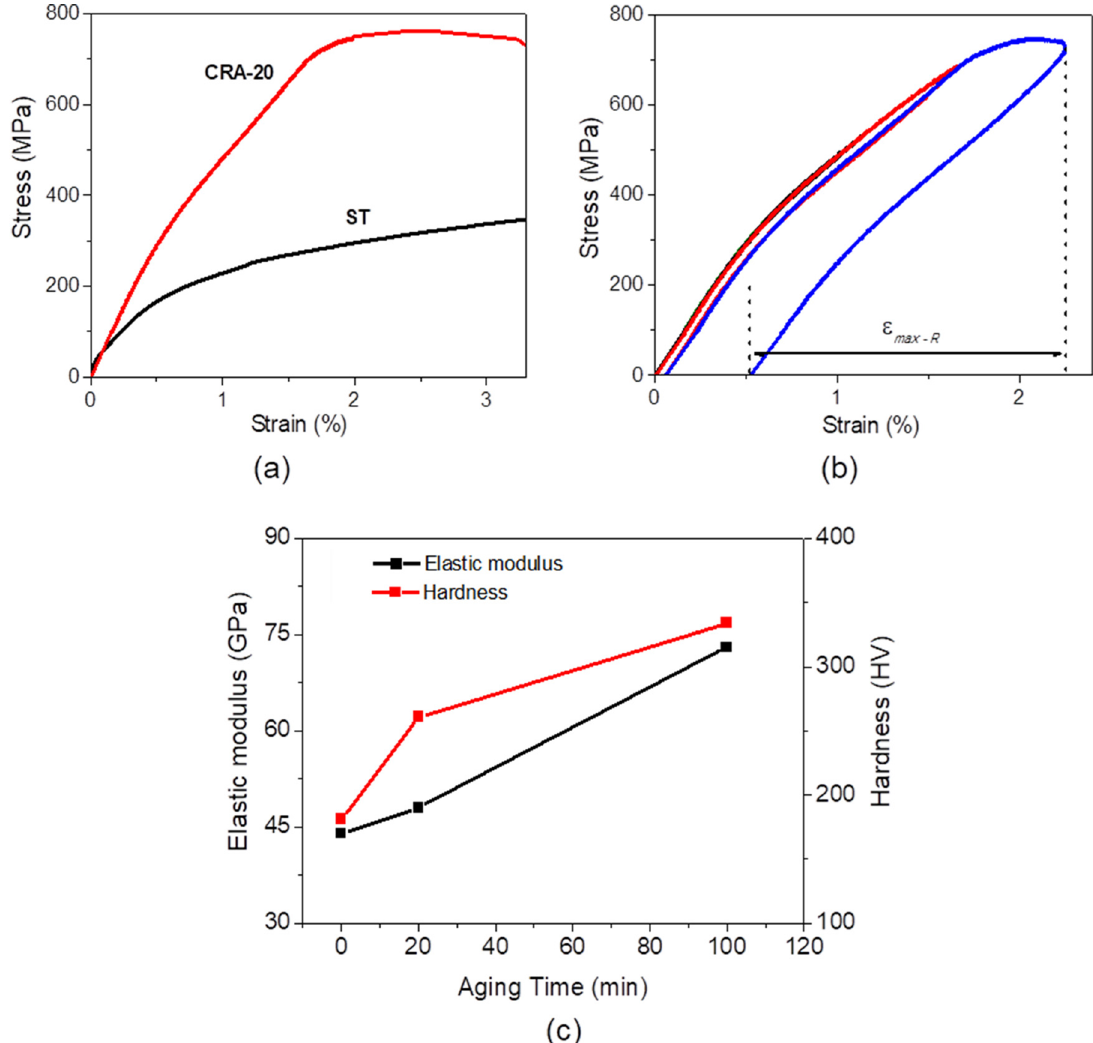
Figure 4. Mechanical behavior of the Ti-35Nb-7Zr-5Ta specimens: (a) representative tensile stress-strain curves of solution treated (ST) and cold rolled plus 20 min aged (CRA-20) specimens; (b) Cyclic tensile stress-strain curves of the CRA-20 specimen; (c) Elastic modulus and Vickers hardness as a function of different aging times at 673